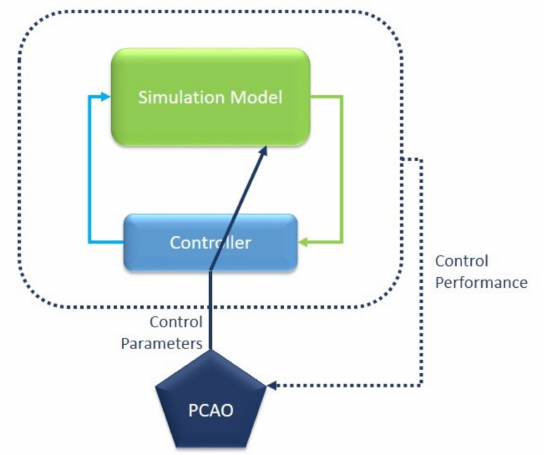
Figure 4. Controller and algorithmic setup.